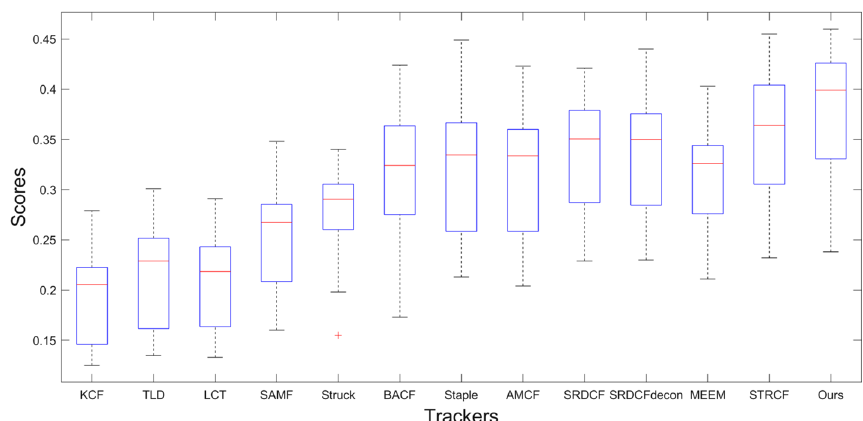
Fig. 9 Analysis of AUC success scores for all trackers with different attributes